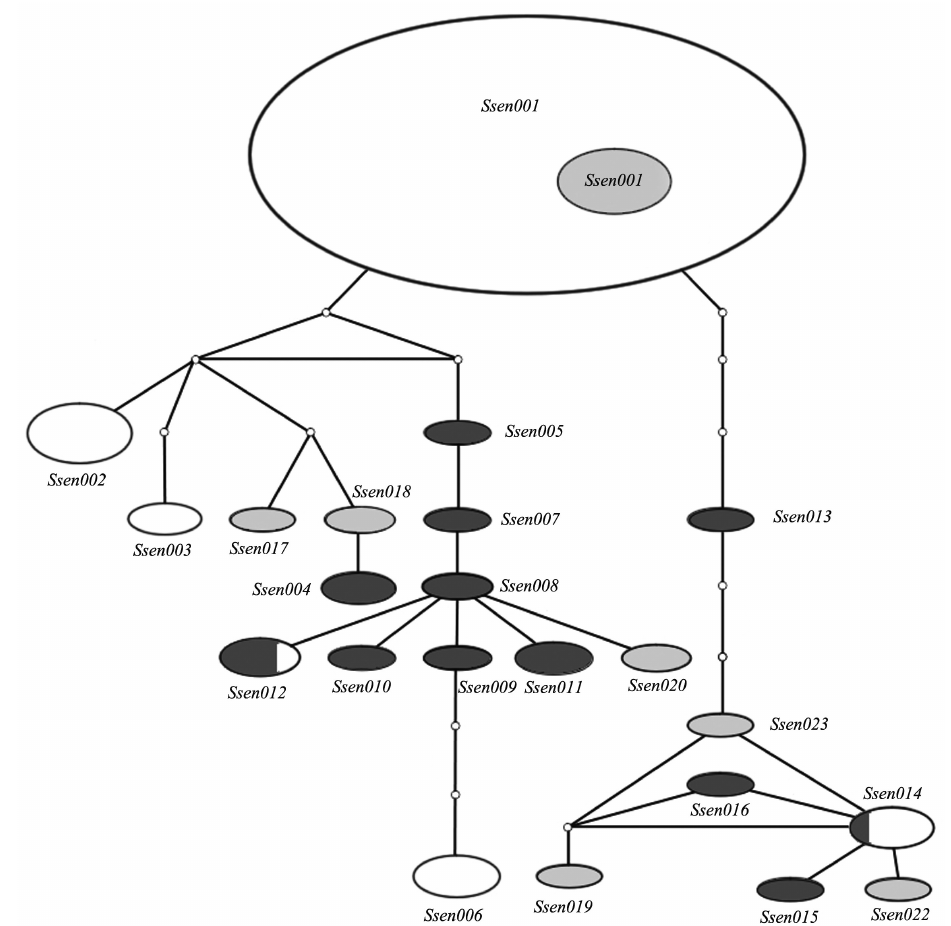
Fig . 1. – Parsimony network estimated in TCS v1.21 for FAR, ATL and MED haplotypes (FAR = farmed Atlantic sample; ATL = wild Atlantic sample; MED = wild Mediterranean sample). The area of the ellipsoids is proportional to the frequency of each haplotype within the pooled populations. Un-sampled or non-existent nodes are represented by small white dots. White, grey and black ellipsoids stand for FAR, ATL and MED,